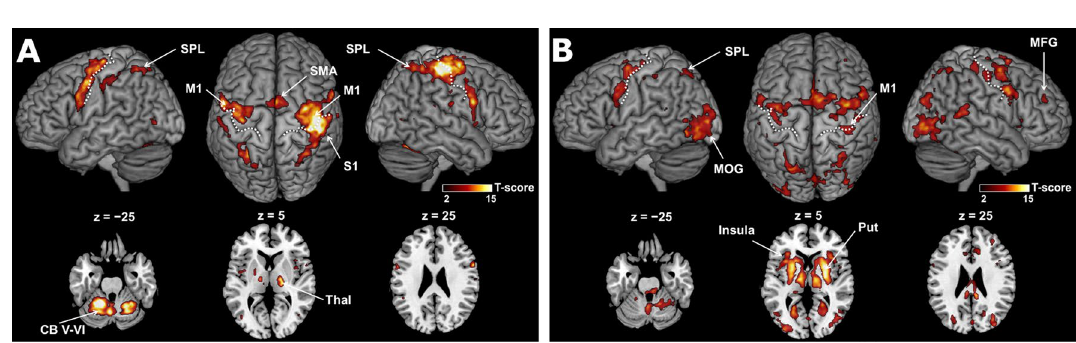
Figure 4. Constant changes during execution and preparation. ( A ) Execution-related and ( B ) preparation- related activity superimposed on the surface-rendered high-resolution magnetic resonance imaging of the template brain. The white dotted lines delineate the central sulcus. The level of statistical significance is set to p < 0.05, family-wise error corrected for multiple comparisons at the voxel-level. CB, cerebellum; SPL, superior parietal lobule; MFG, middle frontal gyrus; MOG, middle occipital gyrus; S1, primary somatosensory cortex; M1, primary motor cortex; Thal, thalamus; Put, putamen; SMA, supplementary motor